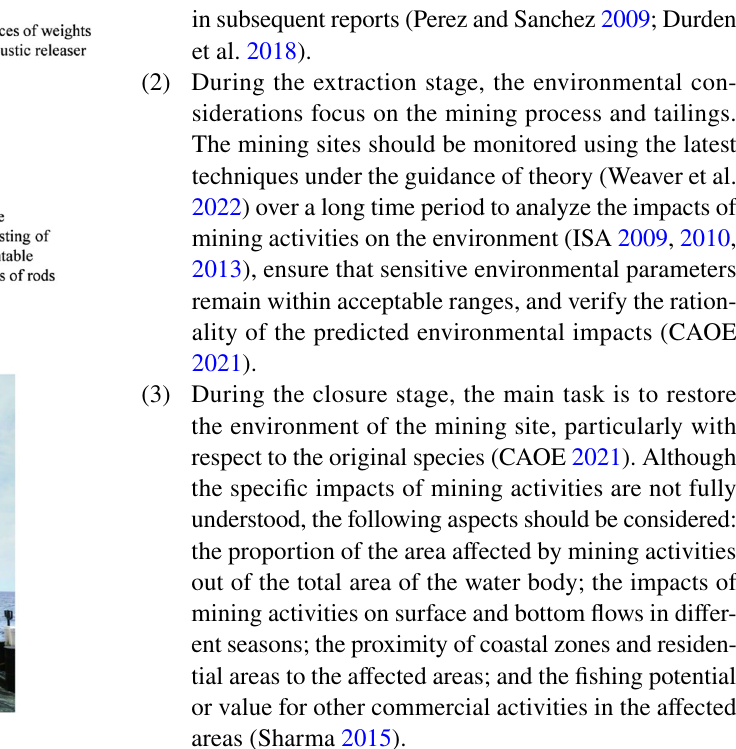
Fig. 20 Tools for the in-situ monitoring of internal changes in geo- logic bodies a Pore pressure probes (Piezometer probes) (modified from Harvey et al. 1997) b IFREMER Piezometer V2 (Stegmann et al. 2011) and c In-situ long-term monitoring system (Sun et al.